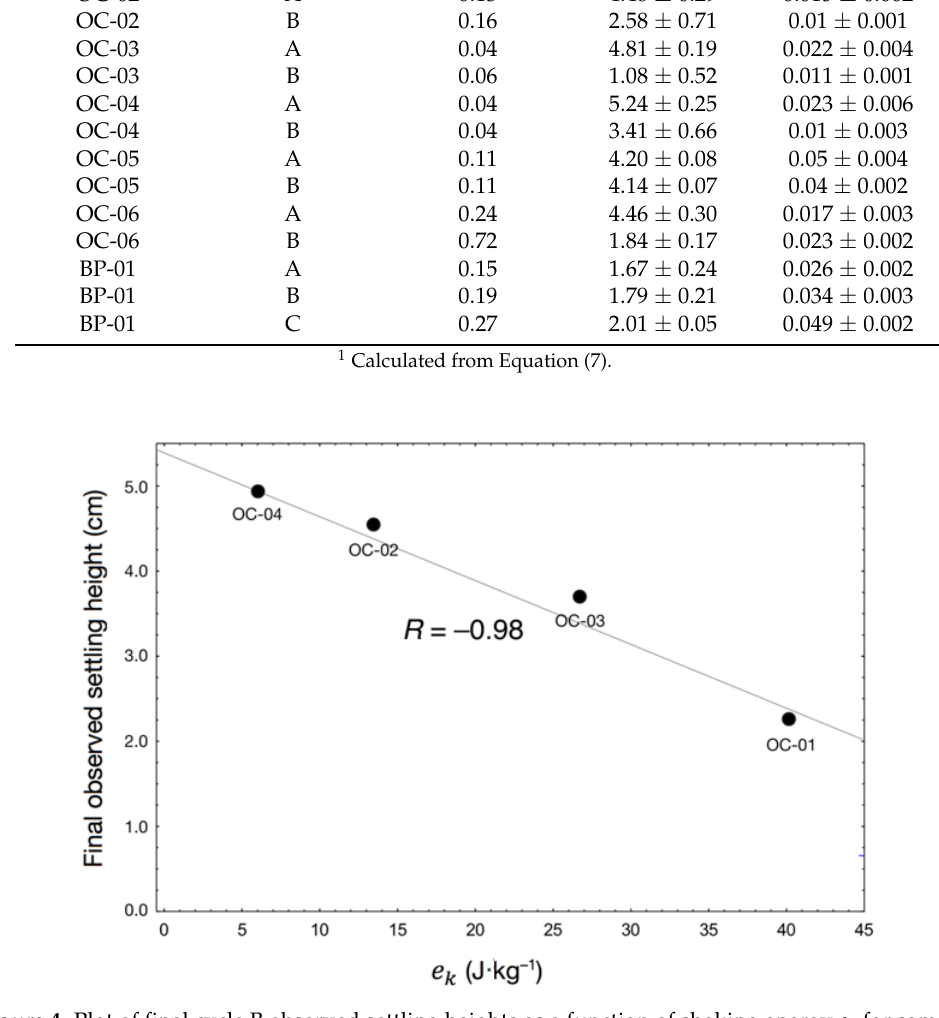
Figure 5. Scatter plot comparing the relationships between equilibrium BIOS solids concentration and settling rate constant for the general cases “before shaking” (blue) and “after shaking” (red) with sample- and cycle-marked data points (e.g., OC-01A, OC-02B) and solid regression lines with dotted 90% confidence intervals. 3.3. Gravimetric and Volumetric Analyses Starting solids volume fractions ( 𝜙 0 ) for the homogenous suspensions are presented in Table 4, along with BIOS solid volumes ( 𝑉 𝐵𝐼𝑂𝑆 ) derived from measured dry weights ( 𝑚 𝐵𝐼𝑂𝑆 ). All volume fraction quantities are reported in permille (‰). BIOS dry weights ranged from 0.043 to 0.106 g, equivalent to volumes of 0.02 to 0.05 mL.